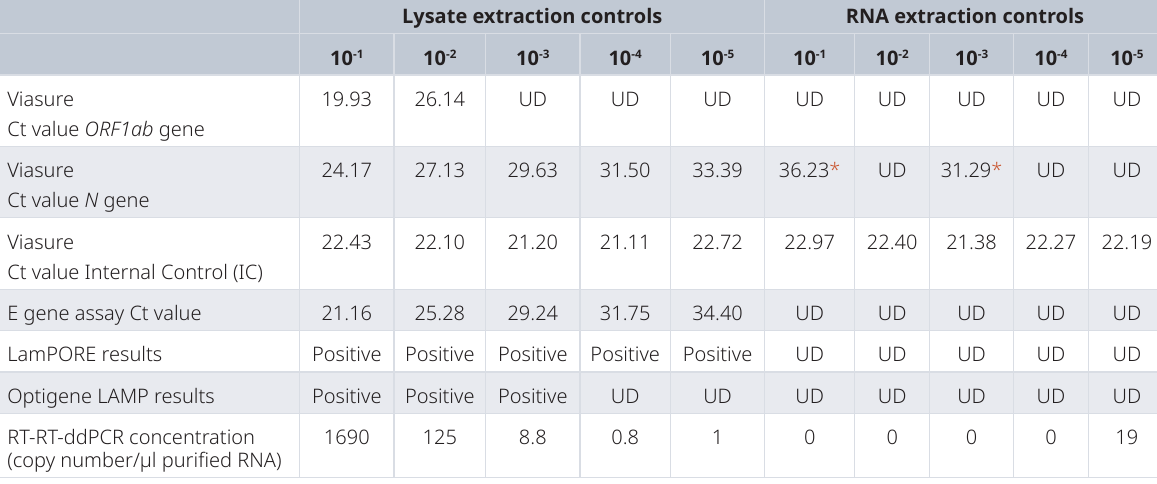
Table 3. Amplification results of dilutions of RNA and cell lysate extracted Bristol control